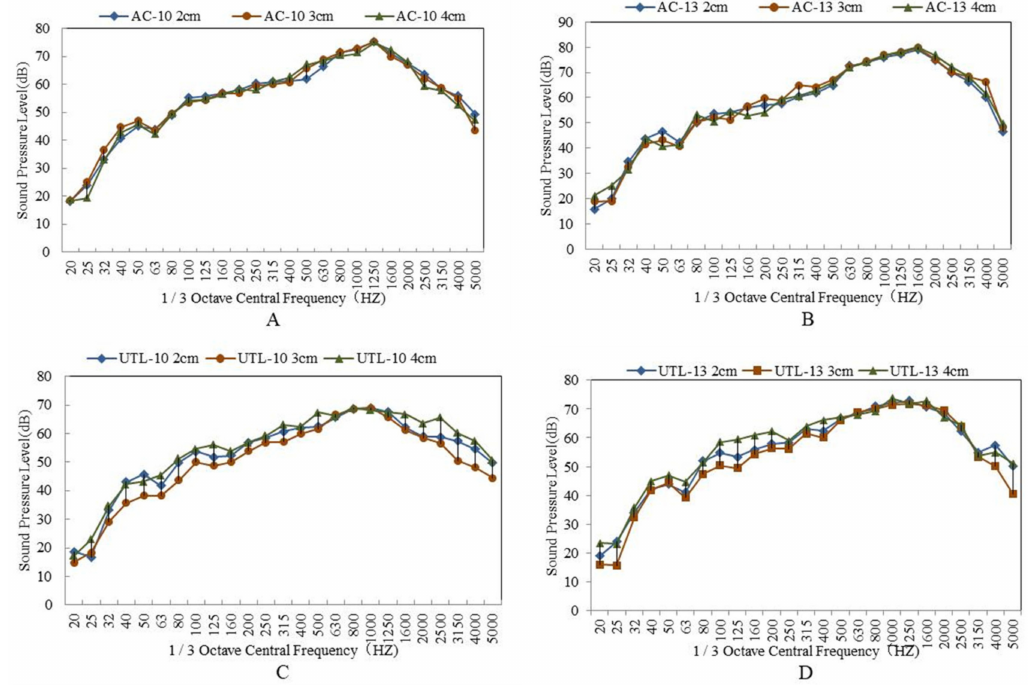
Figure 11. 1 / 3 octave band spectrum of asphalt mixture with di ff erent pavement thickness: ( A ) AC-10; ( B ) AC-13; ( C ) UTL-10; ( D ) UTL-13.